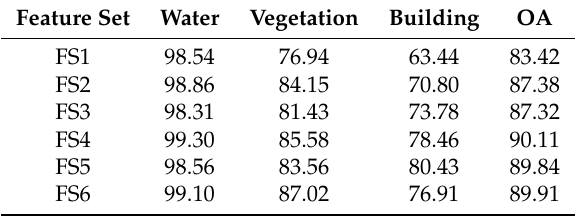
Table 7. Accuracies by classes and OAs with different feature sets on data set A (%). Feature